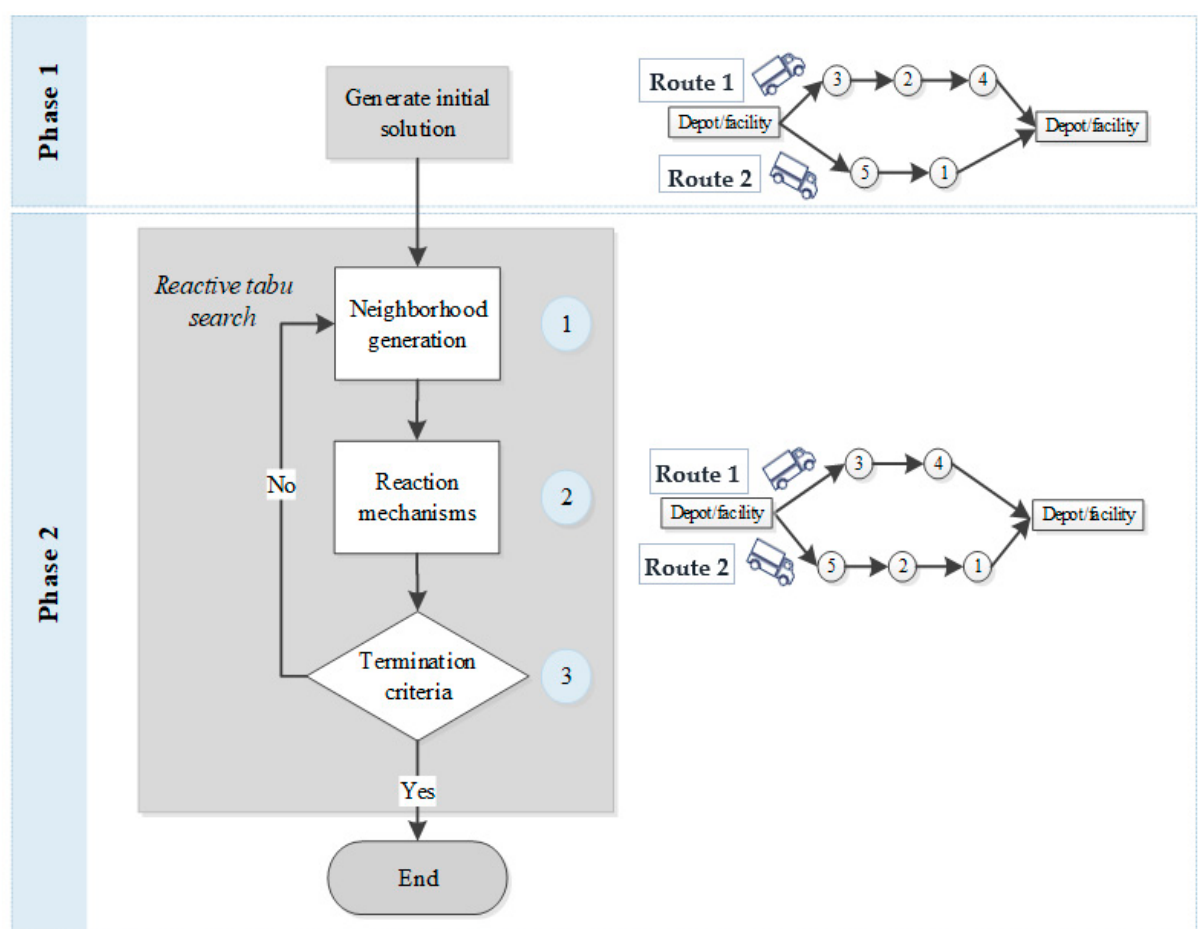
Figure 3. Flowchart of developed solution methodology.